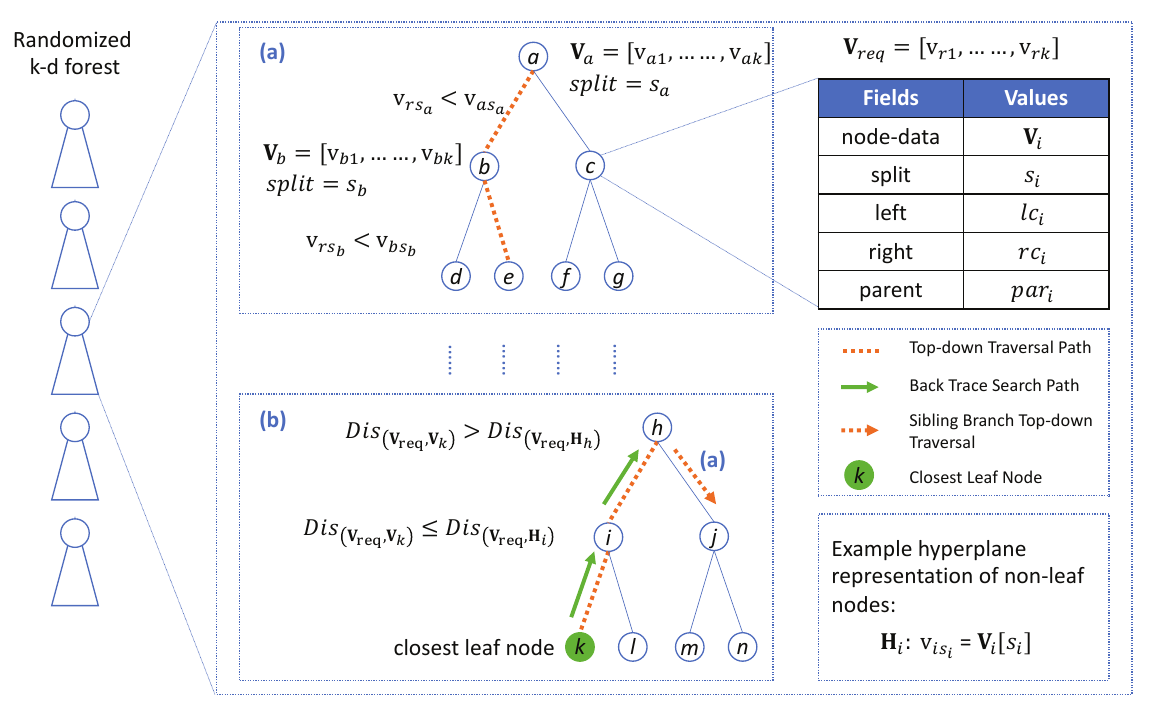
Figure 2. V is the request vector and each V req and Dis ( V H is the distance between the request vector V req , i ) priority queue Queue . (a) represents top-down traversal and (b) represents back trace search. RF , standing for P L 1 C and P KLC for RKDF. P L 1 C −